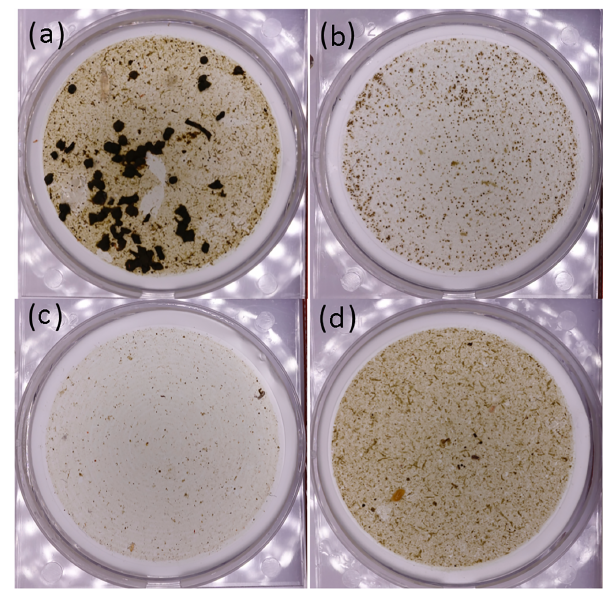
Figure Appendix A5. Representative images of sampled partic- ulate from locations 1–4. The process of sampling retains the morphology of cohesive aggregates. Turbulence on transit from imaging stage to bottle disrupts the integrity of loosely aggre- gated millimeter-sized particles, as represented in Fig. 3d. (a) Lo- cation 1. CFE 002 dive 42 – days 160.623 to 160.791 –